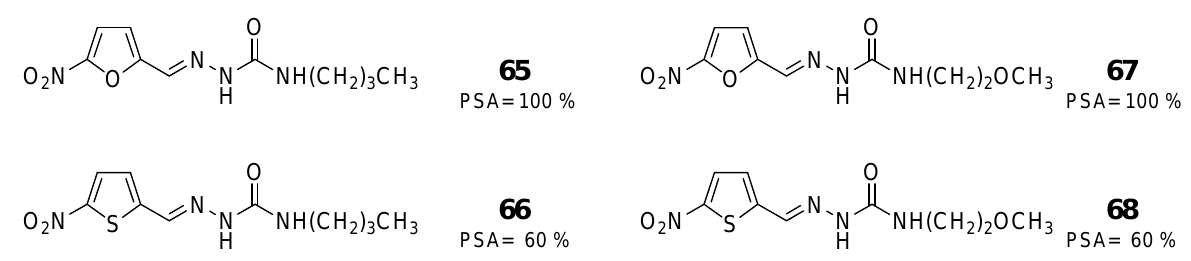
Figure 5. Examples of anti- T. cruzi products hitherto at the “hit-to-lead” development phase from our